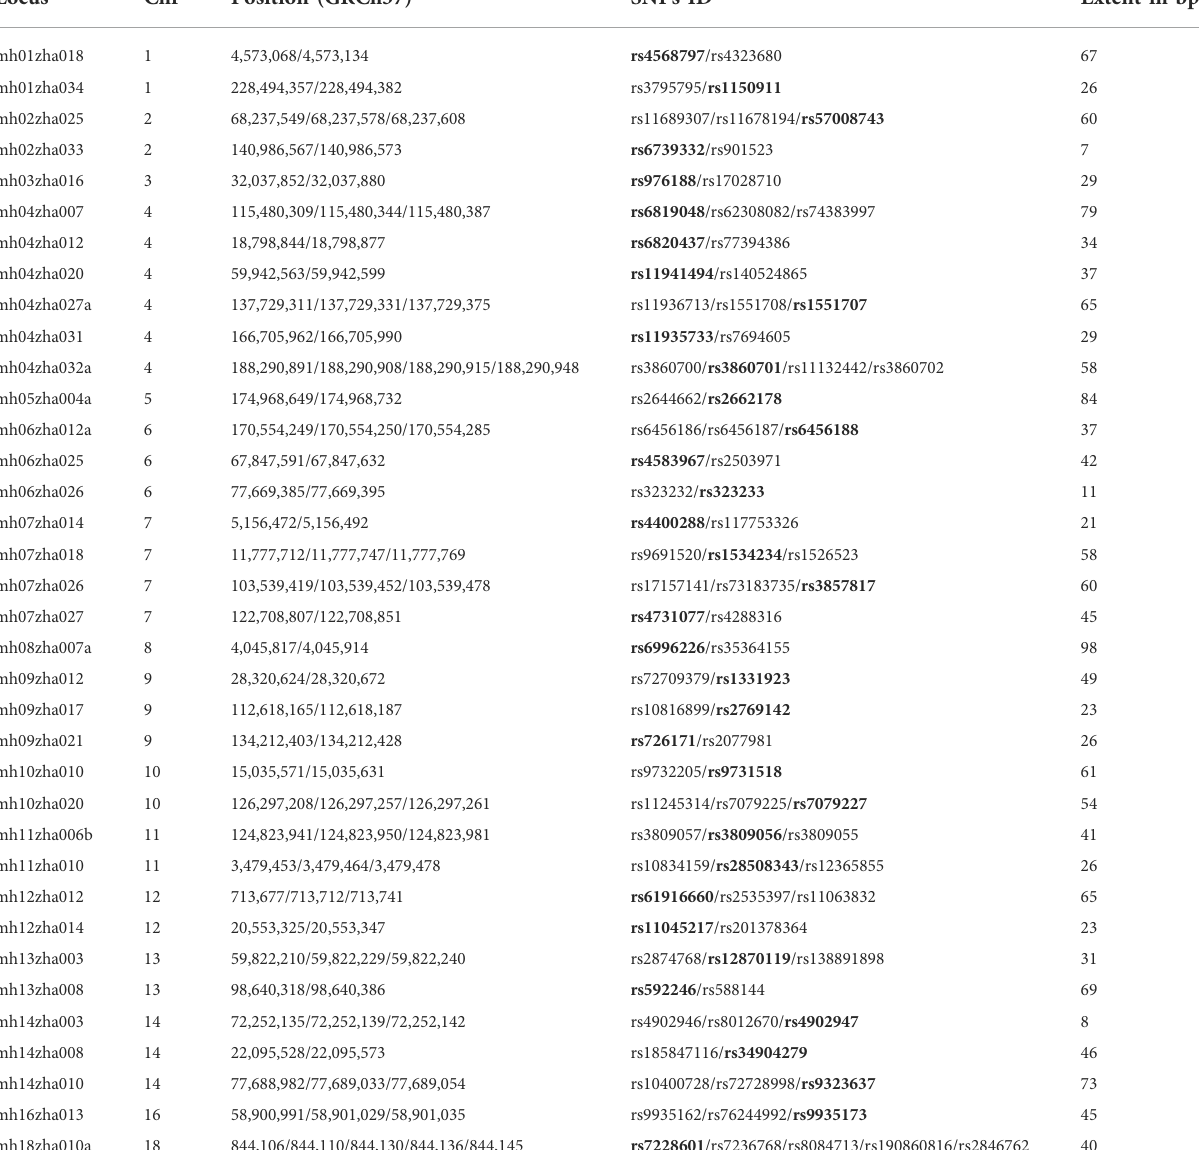
TABLE 1 The details of the selected microhaplotype